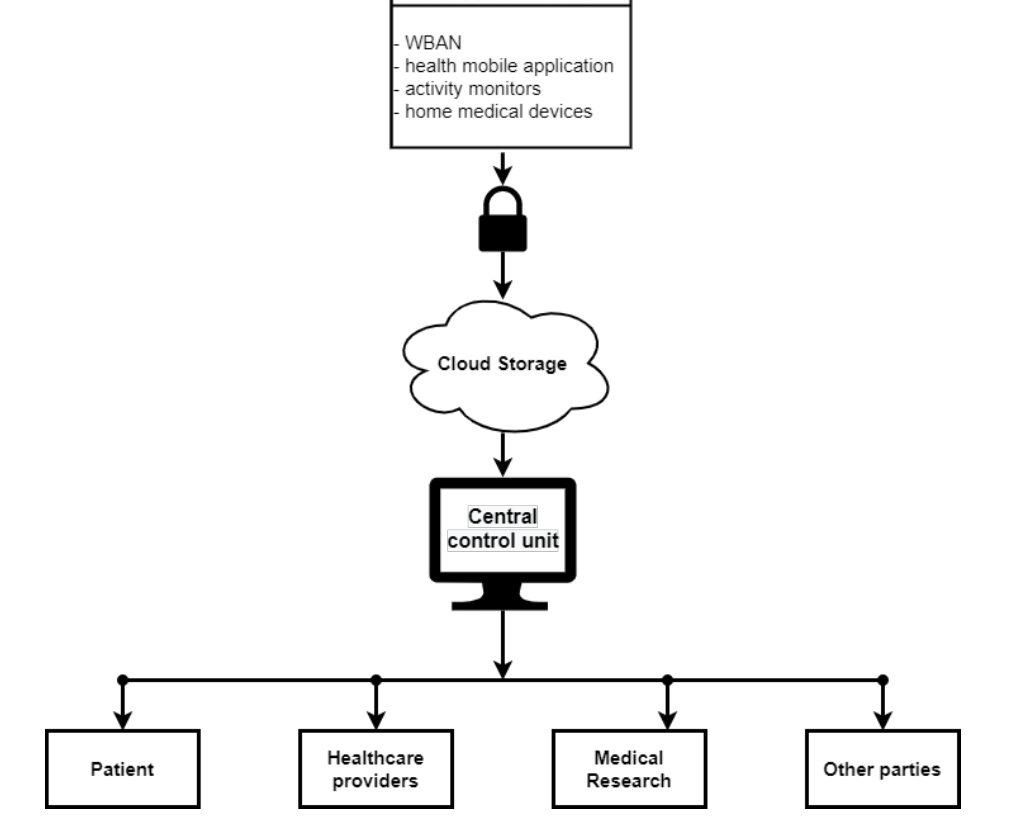
Figure 2. Common mHealth